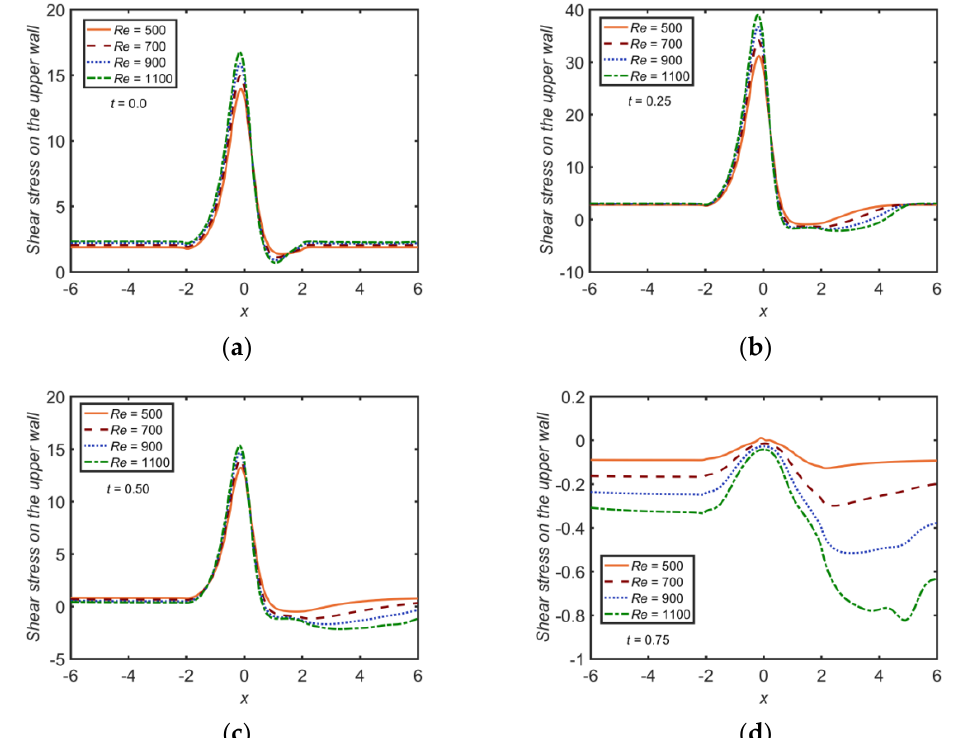
Figure 7. Impact on the WSS distribution on varying the values of Re with M = 5, St = 0.02, and K = 0.6 at ( a ) t = 0, ( b ) t = 0.25, ( c ) t = 0.50, and ( d ) t =